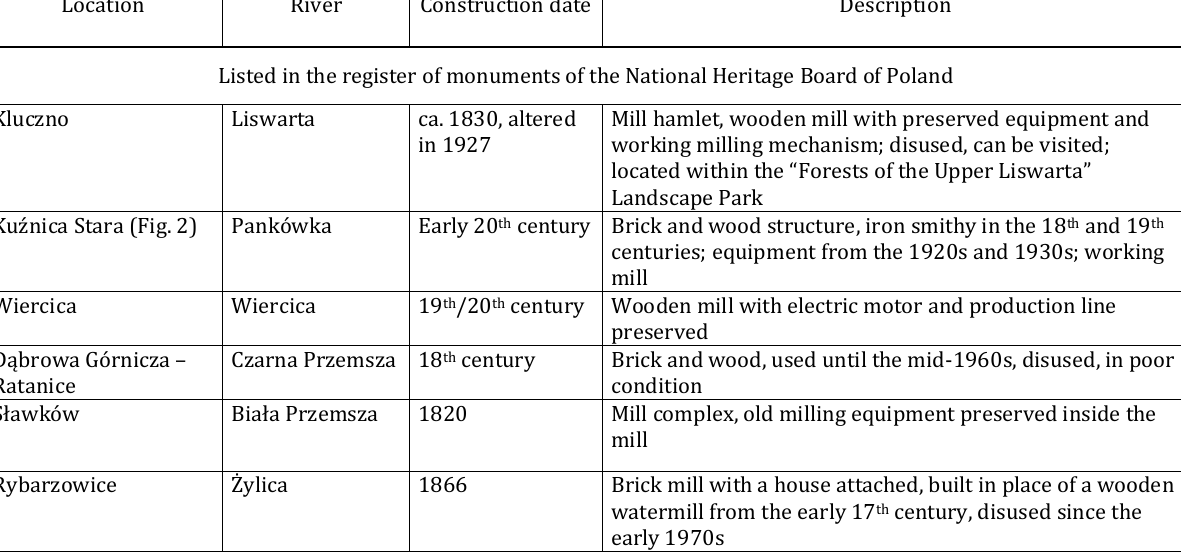
Table 2. Historic watermills in the Silesian voivodeship (own research on the basis of: Rejestr zabytków... and www.zabytkitechniki.pl/) Location River Construction